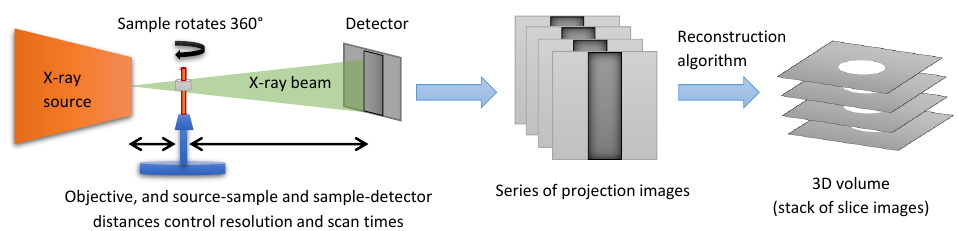
Figure 3. Schematic of a typical laboratory microfocus X-ray CT acquisition system, showing the source, sample with sample holder, and flat-panel detector. Source-sample and sample-detector distances affect image magnification. A series of projection images is captured while rotating the sample, commonly over 360 ◦ , which is then reconstructed into the slice images that form the 3D data